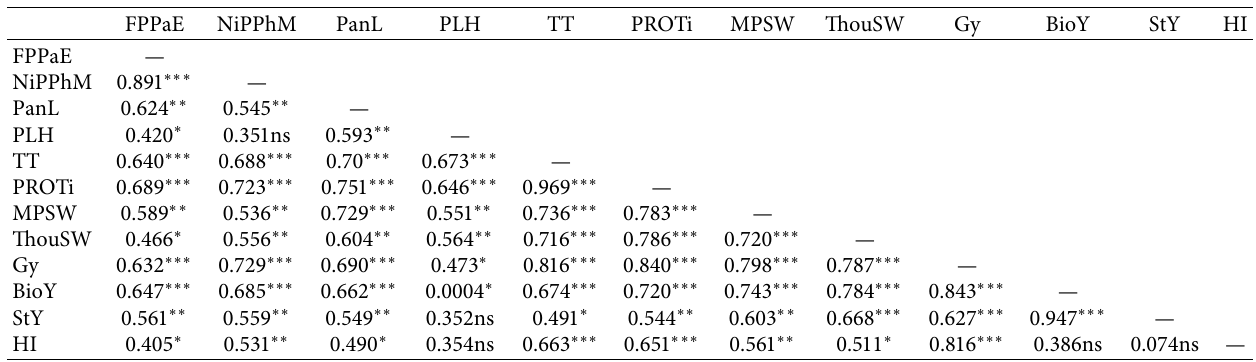
Table 6: Pearson’s